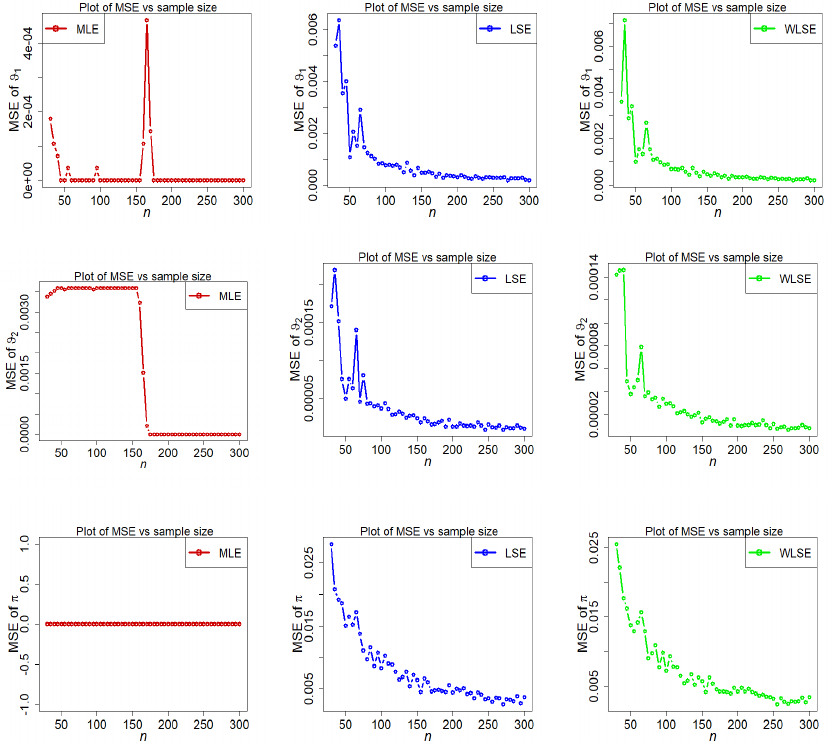
Fig. 12. Fluctuations of MSE of estimators under di⁄erent methods for parametric set III. Figure 12. Fluctuations of MSE of estimators under different methods for parametric set